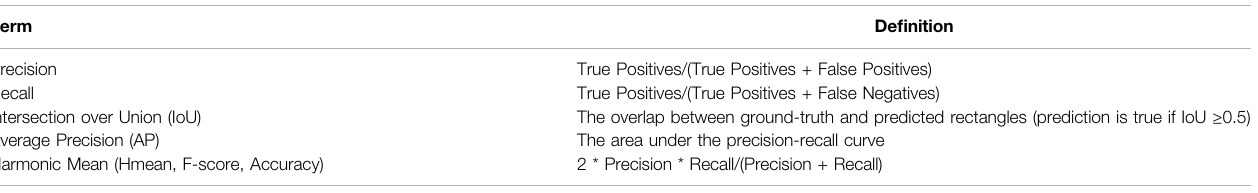
TABLE 3 | Metrics/terms used in evaluating the results. Term De fi nition Precision